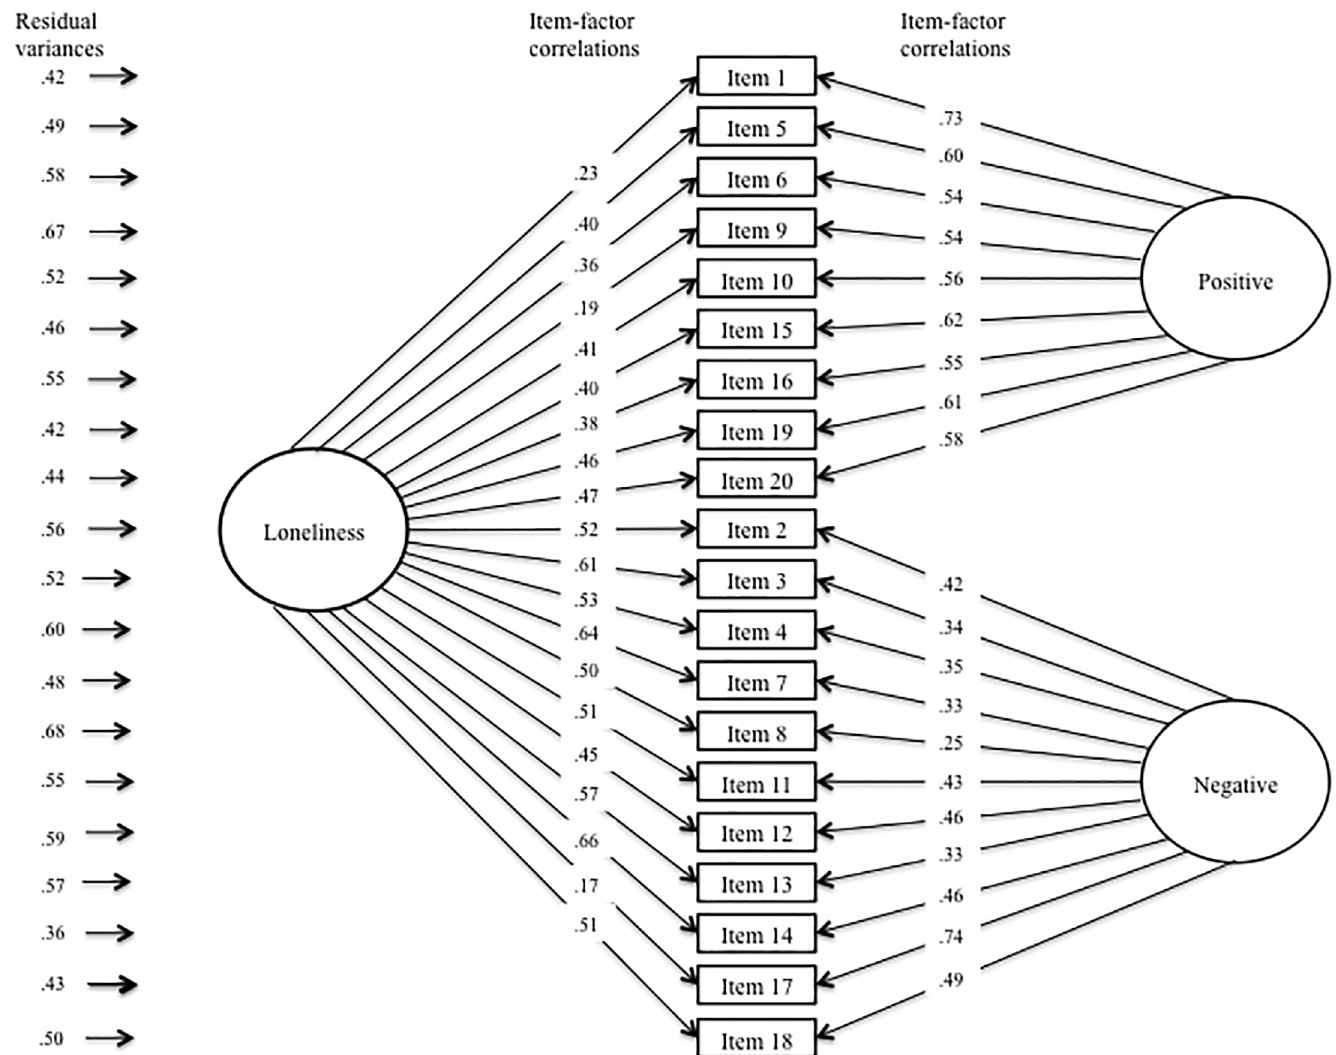
Fig 2. Completely standardized factor model of the UCLA-3 in the schizophrenia group. Note . Depicted are the completely standardized parameter estimates of the final measurement invariance model; equality constraints were imposed on the unstandardized parameter